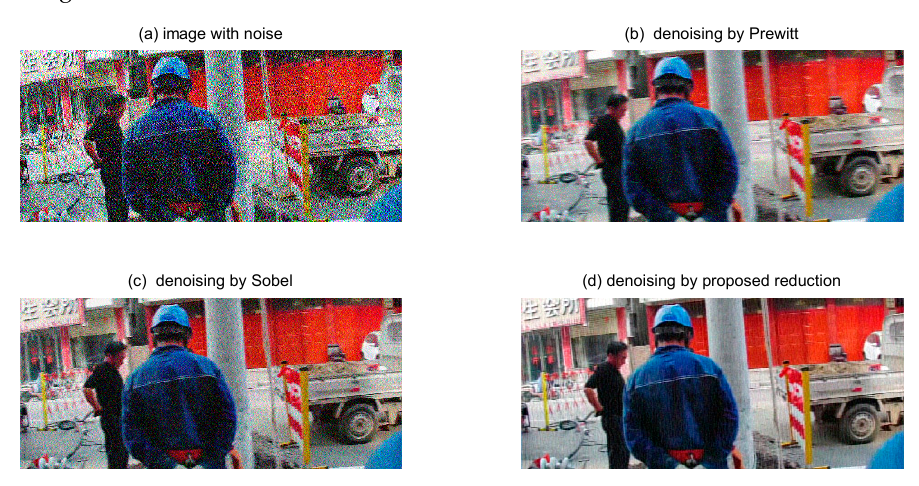
Figure 5. Filtering e ff ect for noise.